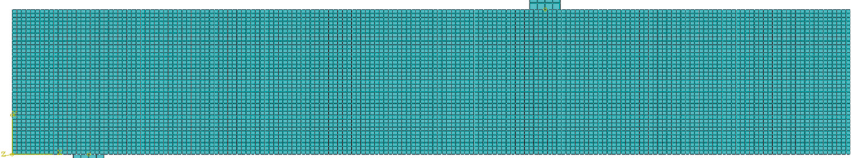
Figure 8: Mesh division of GFRP fiber reinforced concrete beam model.